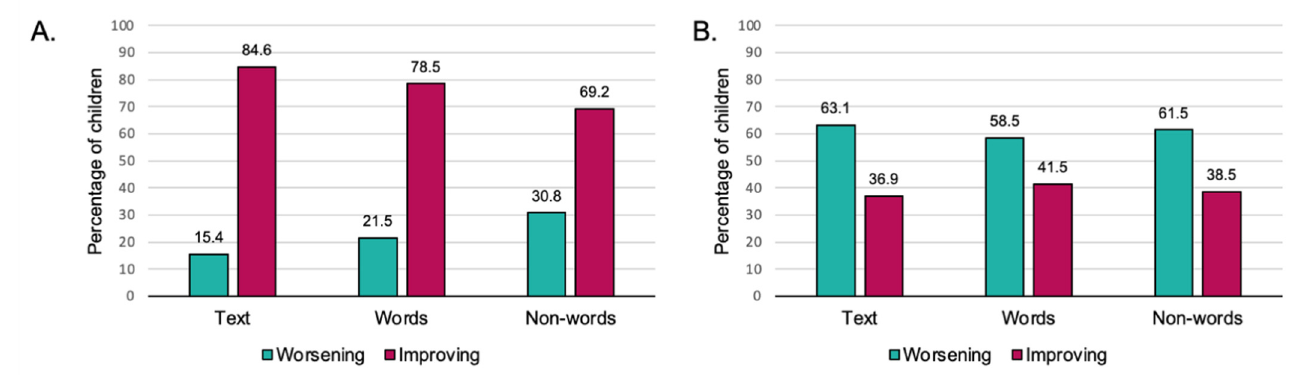
Figure 3. Percentages of DG children who improved after the lockdown with respect to improve-rate equal to zero ( A ) and equal to 0.30 for words and text and 0.15 for non-words ( B ). Note: DG, dyslexia group.